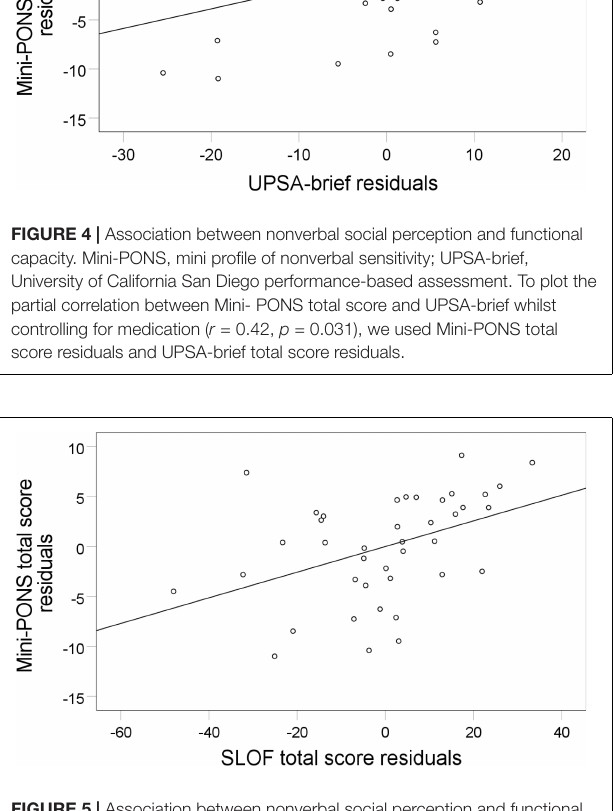
FIGURE 5 | Association between nonverbal social perception and functional outcome. Mini-PONS, mini profile of nonverbal sensitivity; SLOF, specific levels of functioning scale. To plot the partial correlation between Mini-PONS total score and SLOF whilst controlling for medication ( r = 0.41, p = 0.031), we used Mini-PONS total score residuals and SLOF